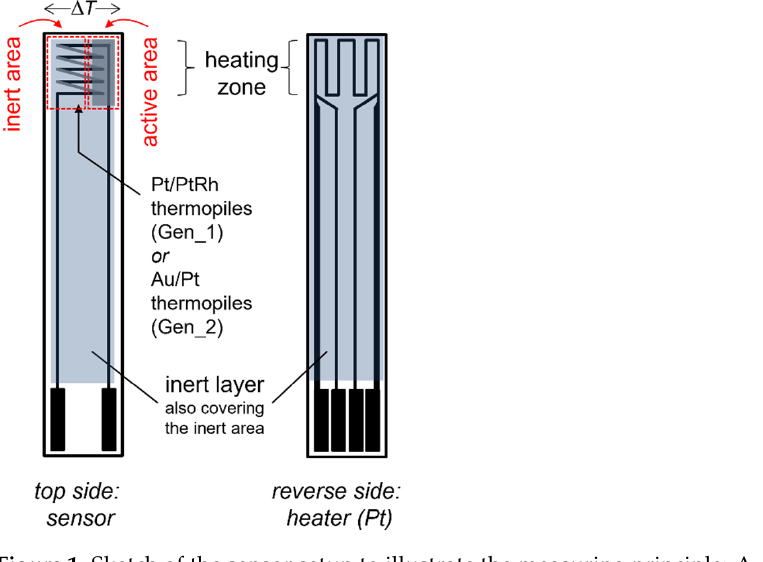
Figure 1. Sketch of the sensor setup to illustrate the measuring principle: A catalytically activated thick-film layer (“active area”) leads to a temperature increase due to exothermic oxidation of the reducing analytes. The screen printed thermopile structure measures the temperature difference of the inert area within the sensor tip as a voltage signal. The heating element on the reverse side provides the required sensor operation temperature.